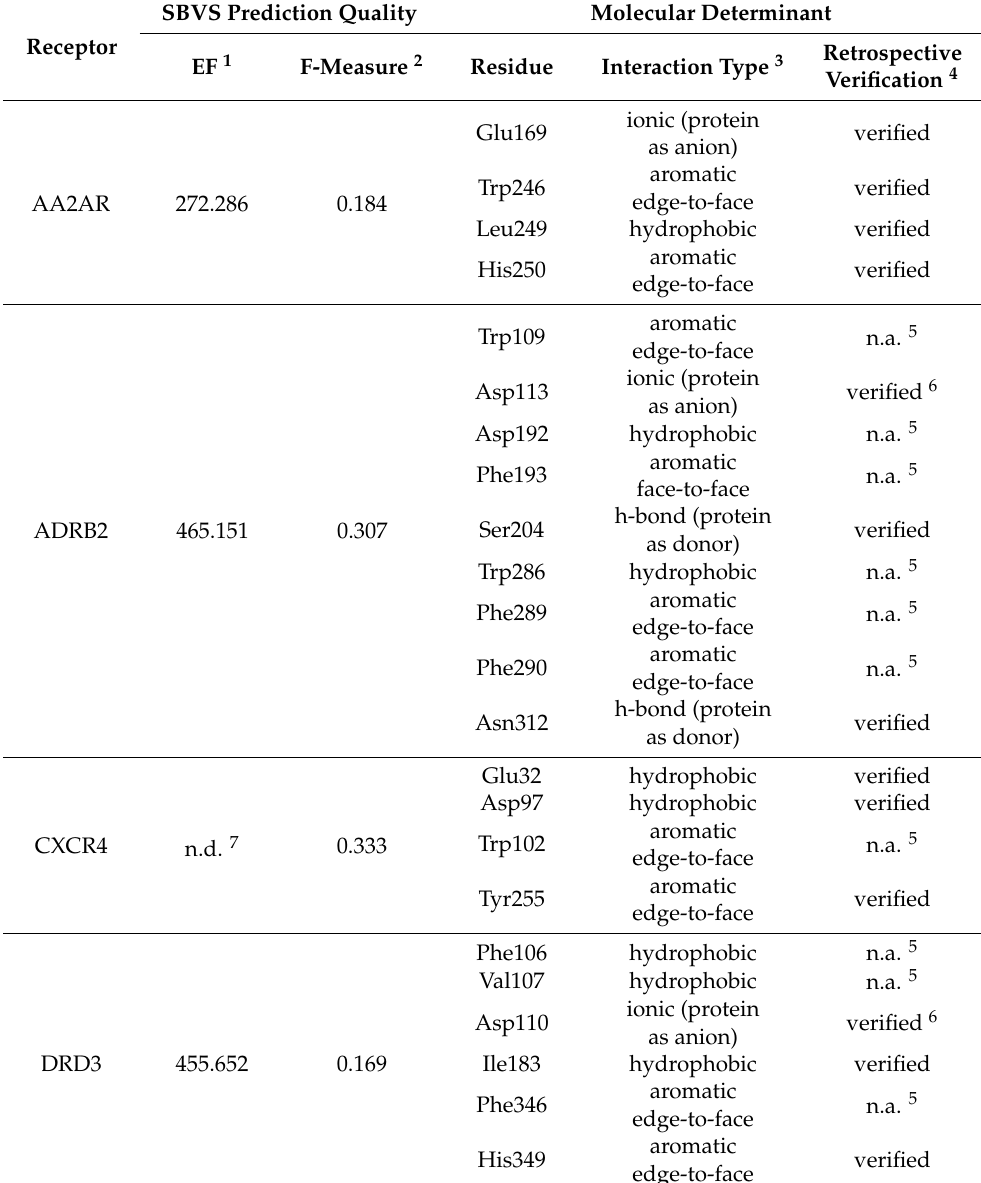
Table 1. The prediction quality of the retrospectively validated structure-based virtual screening (SBVS) protocols and the molecular determinants of the ligand binding to the studied